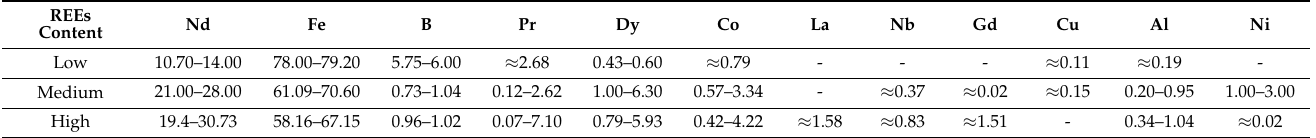
Table 1. Typical chemical compositions of NdFeB magnet scrap